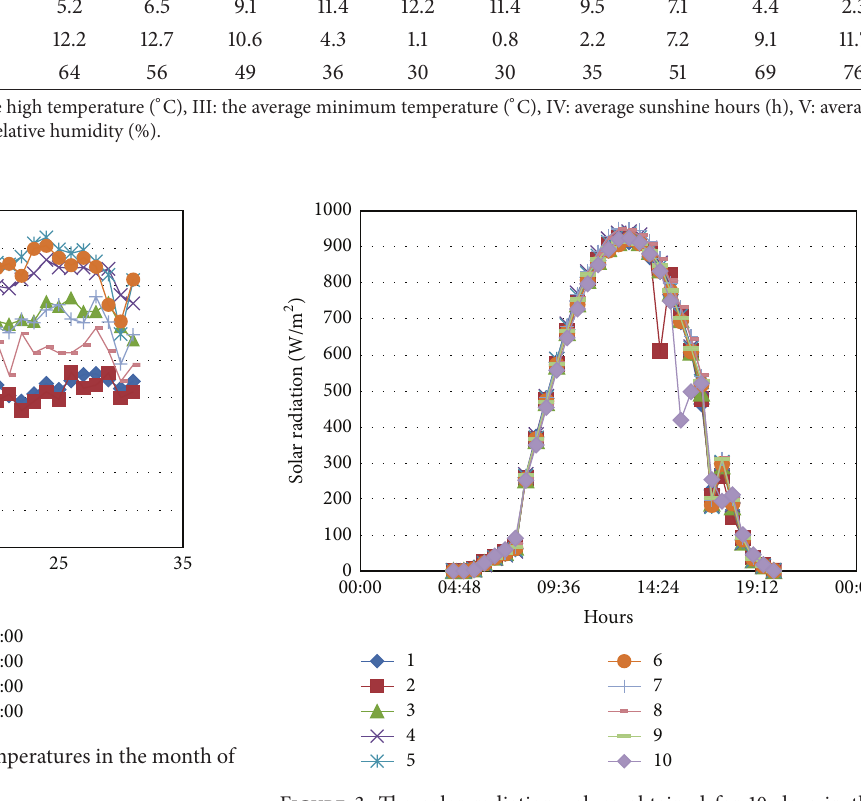
Figure 3: The solar radiation values obtained for 10 days in the month of